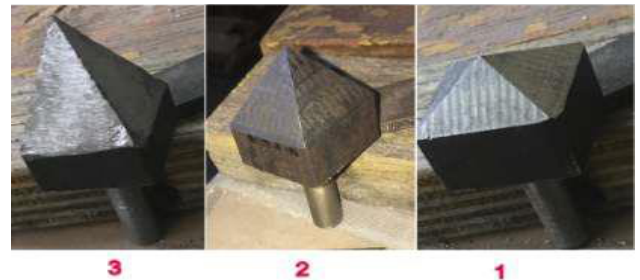
Fig. 3. Pyramid Pole with Different Angles